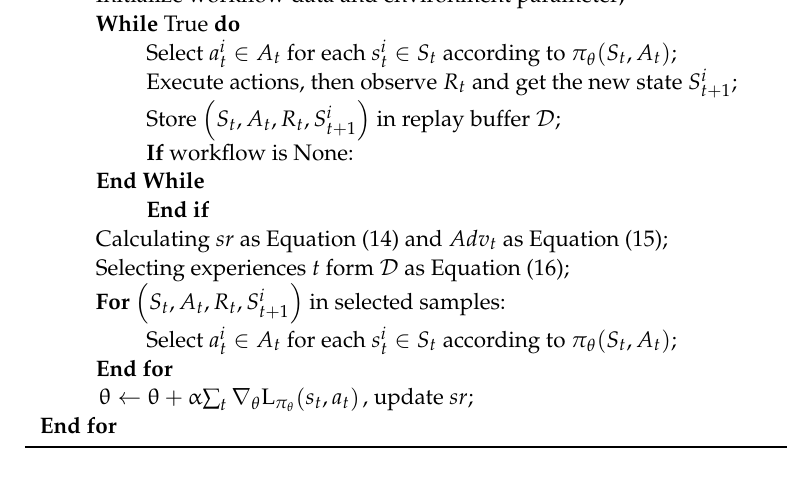
Algorithm 2: The Sampling